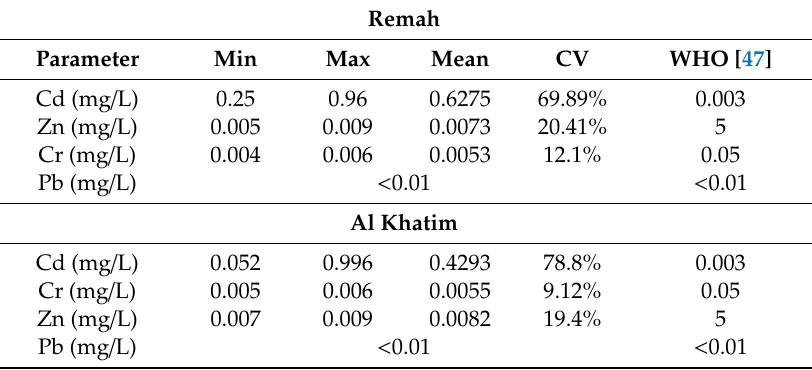
Table 2. Descriptive statistics for trace metal concentration in groundwater in Remah and Al Khatim (CV: coe ffi cient of